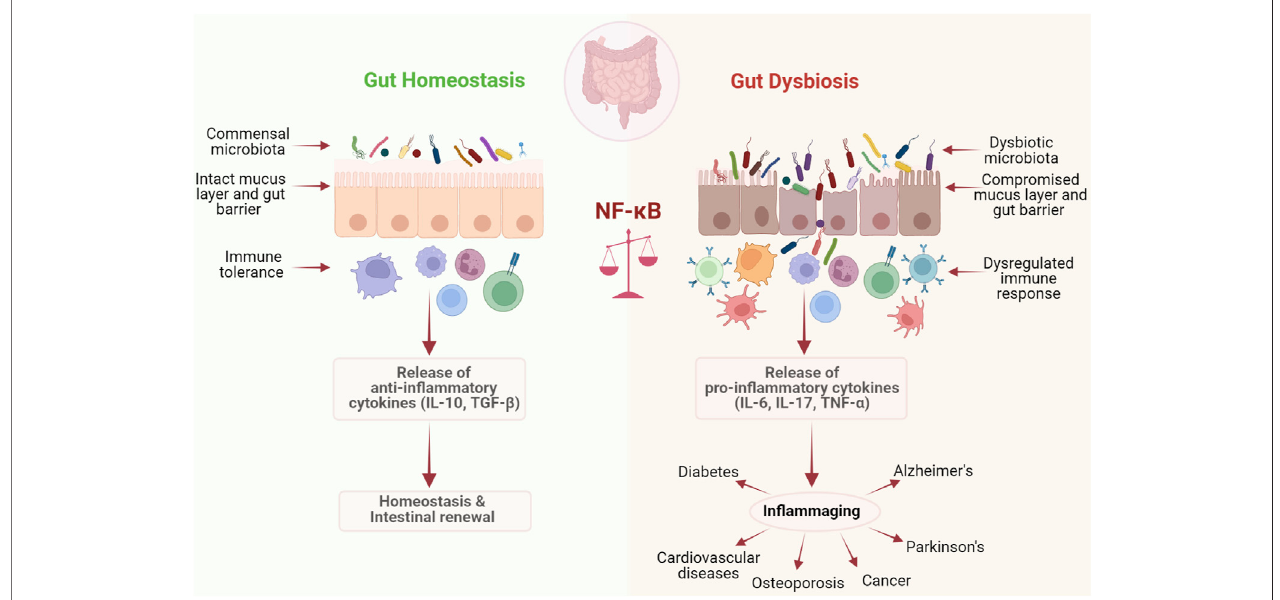
FIGURE 2 | NF- κ B maintains the fi ne balance between homeostasis and dysbiosis. NF- κ B plays a dual role if host response to microbiota. It plays a critical role in maintaining homeostasis by promoting immune tolerance against commensal gut microbiota, while under dysbiotic conditions it drives in fl ammation, leading to a number of chronic